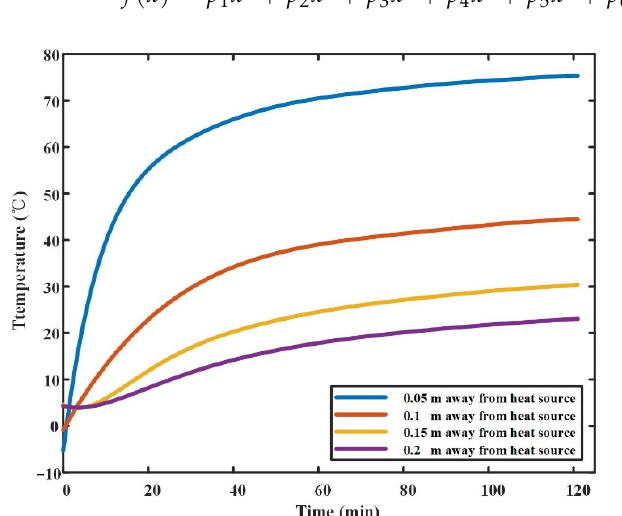
Figure 9. Fitting curve for the temperature ‐ time relationship.